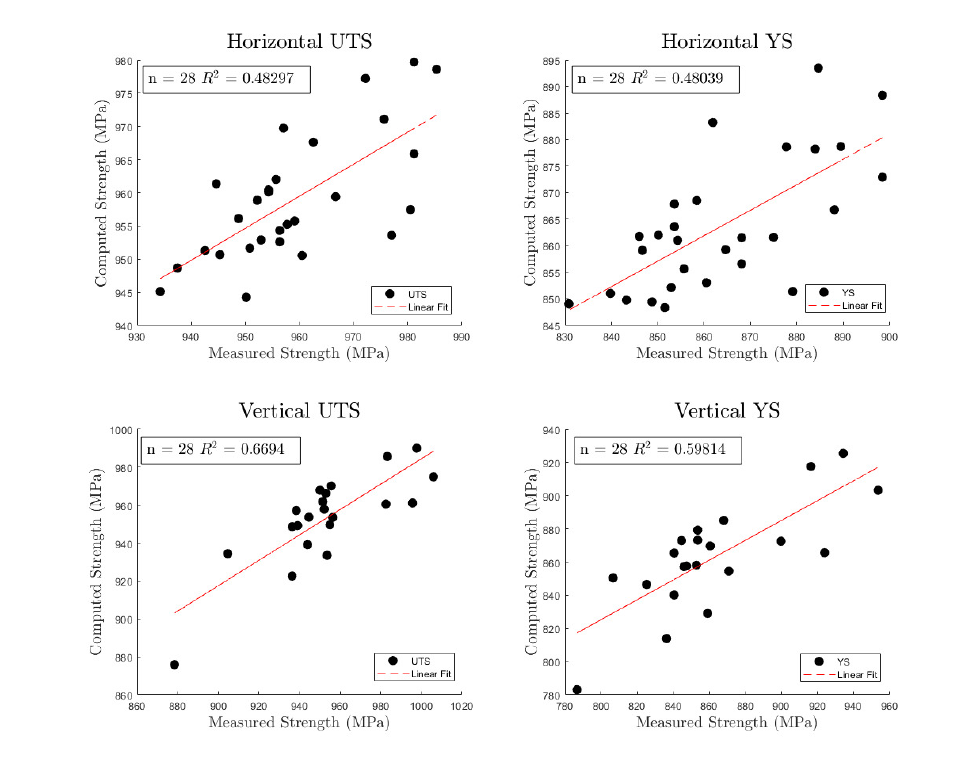
Figure 5. Predicted versus measured UTS and YS (MPa) for the NP1 horizontal and vertical